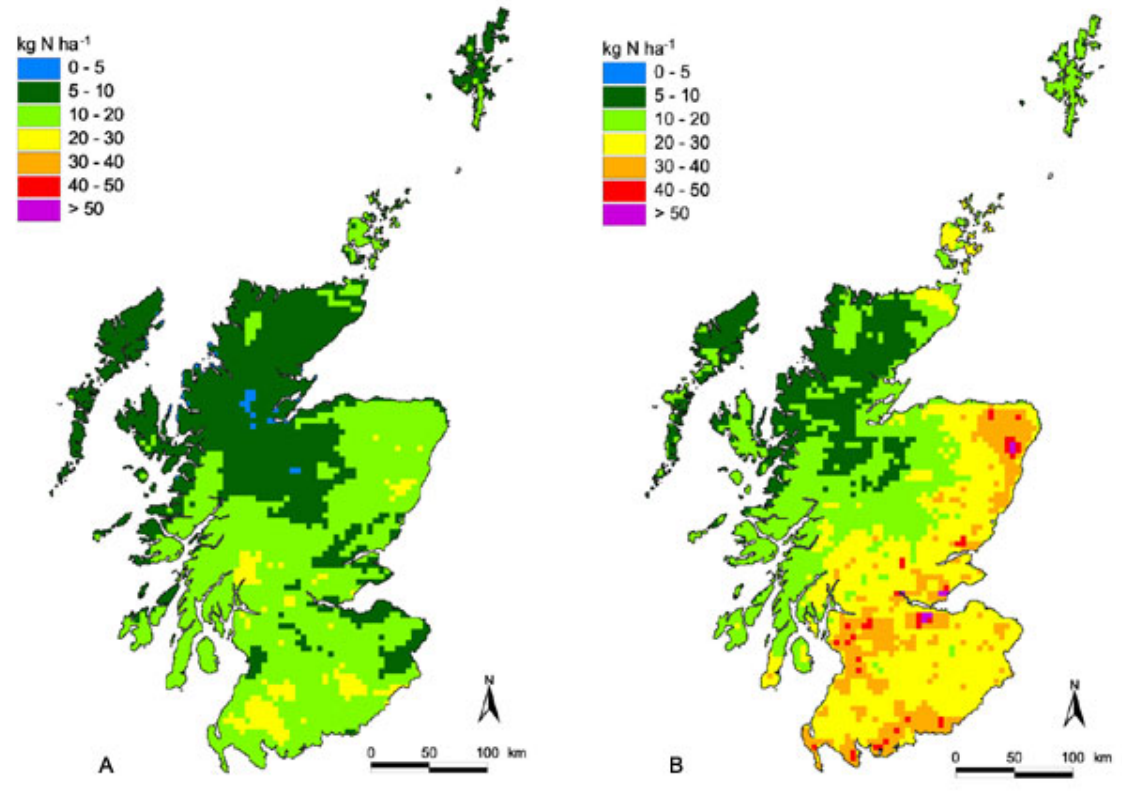
FIGURE 7. Modelled deposition of atmospheric nitrogen to Scotland, including both NH x and NO y for 1996. (A) Average total deposition accounting for the grid-average dry deposition to each 5-km grid square (i.e., net removal from the atmosphere). (B) Total dry deposition as received by woodlands and forest if